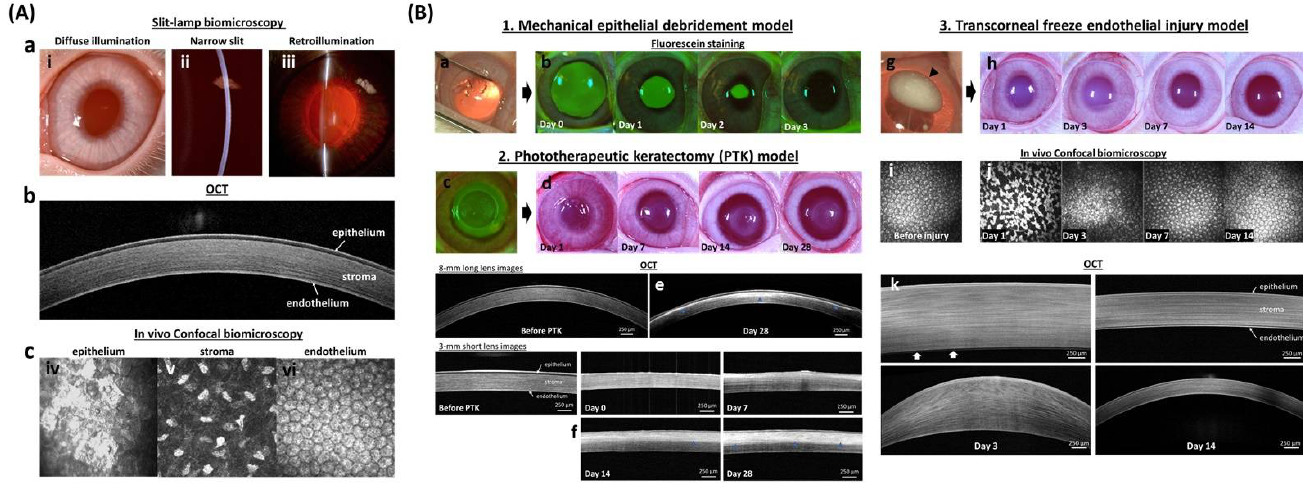
Figure 3. In vivo corneal wound healing model in rabbits. ( A ) In vivo imaging techniques of the normal cornea demonstrate the individual layers with which it is comprised. Digital slit-lamp biomicroscopy ( a ) is used to examine the anterior segment of the eye with diffuse illumination ( i ) used to examine the surface of the eyelid, cornea, and iris. A narrow slit-beam ( ii ) provides a cross-sectional image of the cornea and anterior chamber to determine the depth and character of corneal opacities as well as assess for intraocular inflammation termed and aqueous flare, respectively. Retroillumination ( iii ) demonstrates opacities of the cornea, anterior chamber or lens. Advanced ocular imaging is used to augment slit lamp biomicroscopy with optical coherence tomography ( b ) used for cross-sectional corneal imaging, while in vivo confocal biomicroscopy ( c ) shows individual cells of each corneal layer including the epithelium ( iv ), keratocytes in the stroma ( v ), and endothelium ( vi ). ( B ) Wound healing models for each corneal layer are well optimized to study both toxicity and drug efficacy. The mechanical debridement model ( 1 ) is used for corneal epithelial wound healing. The wound